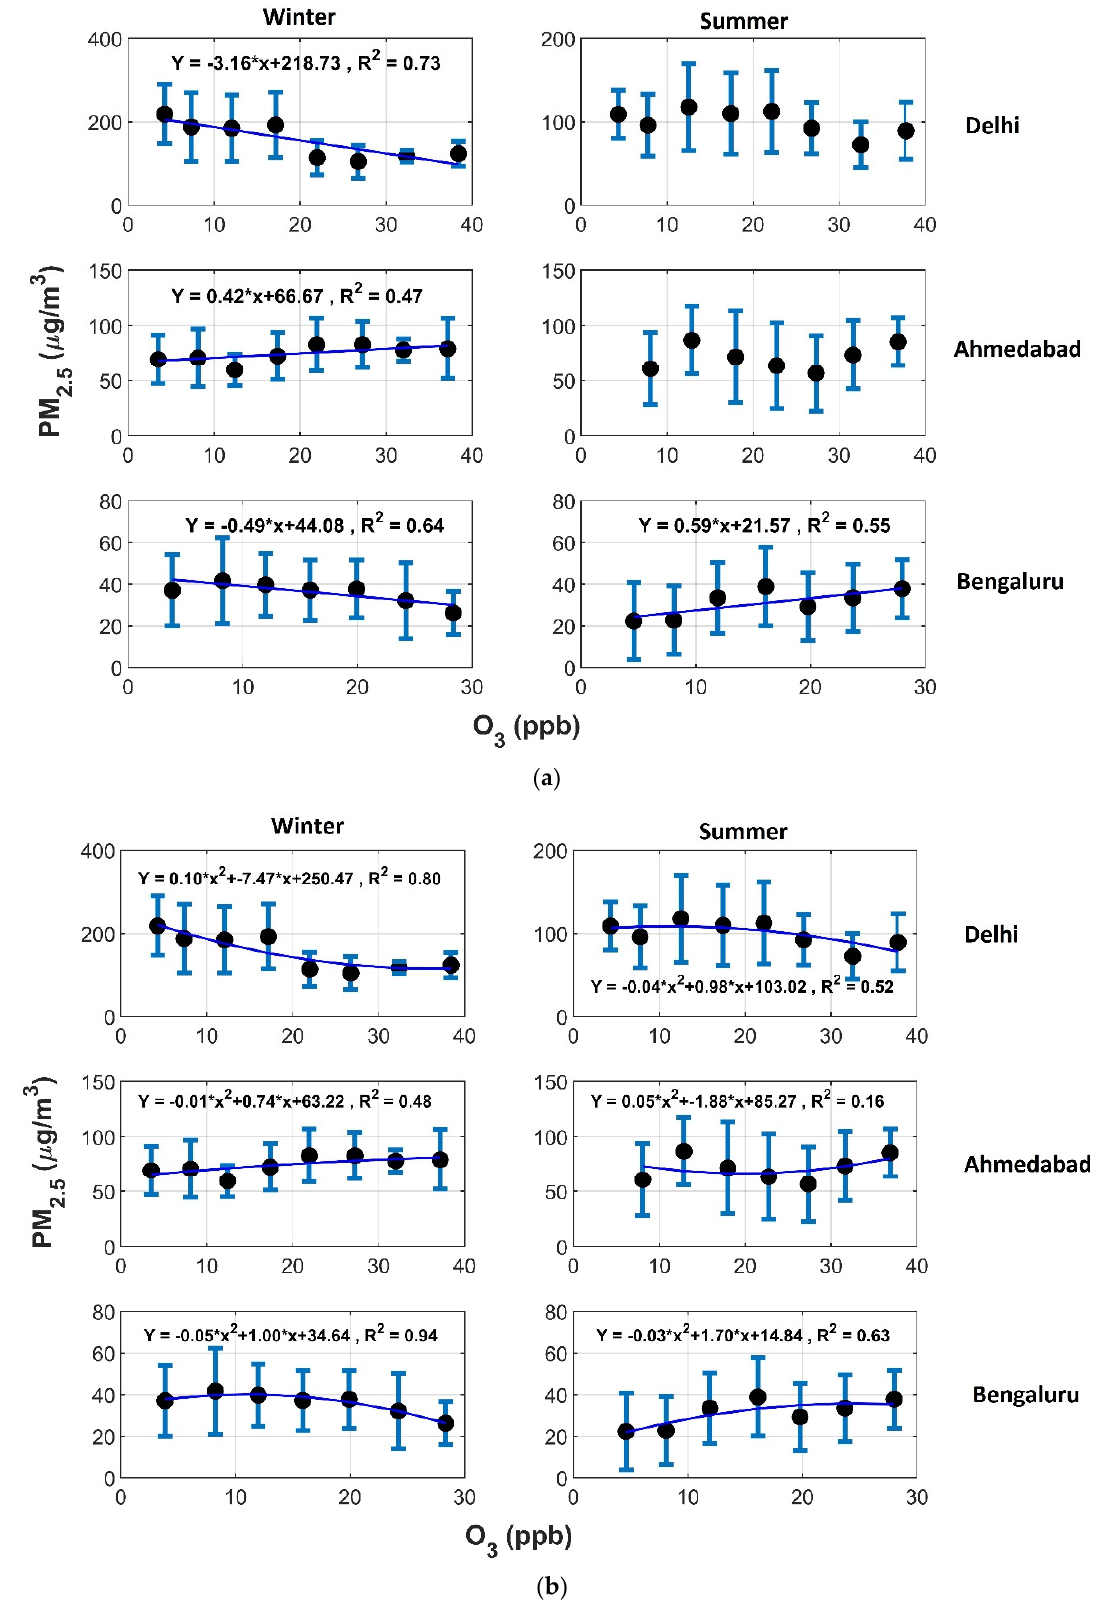
Figure 4. Dependence of PM 2.5 concentrations on O 3 , ( a ) linear and ( b ) quadratic, during the summer and winter seasons for the three study locations.